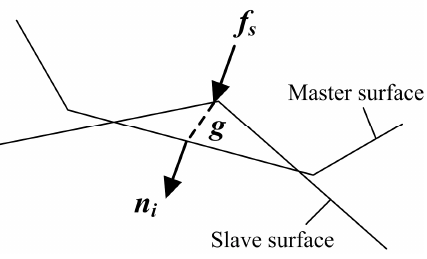
Figure 5. Node penetrates the master surface.